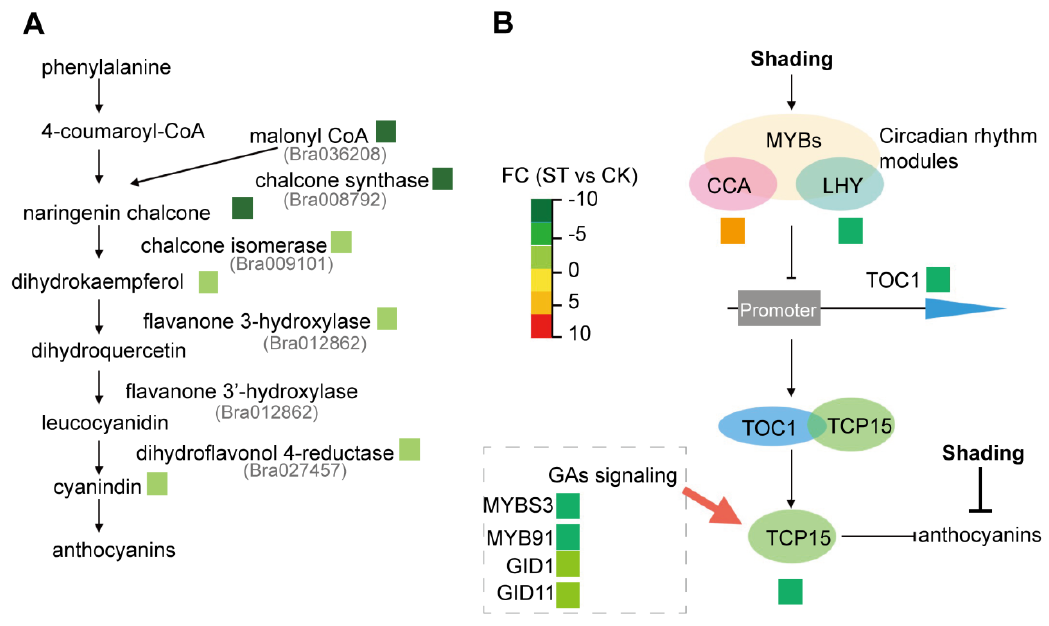
Figure 9. Working model showing anthocyanin metabolic pathway in response to low light treatments. ( A ) Anthocyanin biosynthetic pathway in response to low light treatments in XH1. ( B ) Proposed molecular mechanism that low light inhibits anthocyanin biosynthesis through stimulating BrTCP15 gene expression coordinated with some other pathways such as circadian rhythm. The gene ID of MYBS3, MYB91, GID1 and GID11 are Bra002790, Bra005177, Bra005899 and Bra009207, respectively. CCA, LHY and TOC1 are Bra004503, Bra028258 and Bra035933, respectively. All the differentially expressed genes were listed in Table